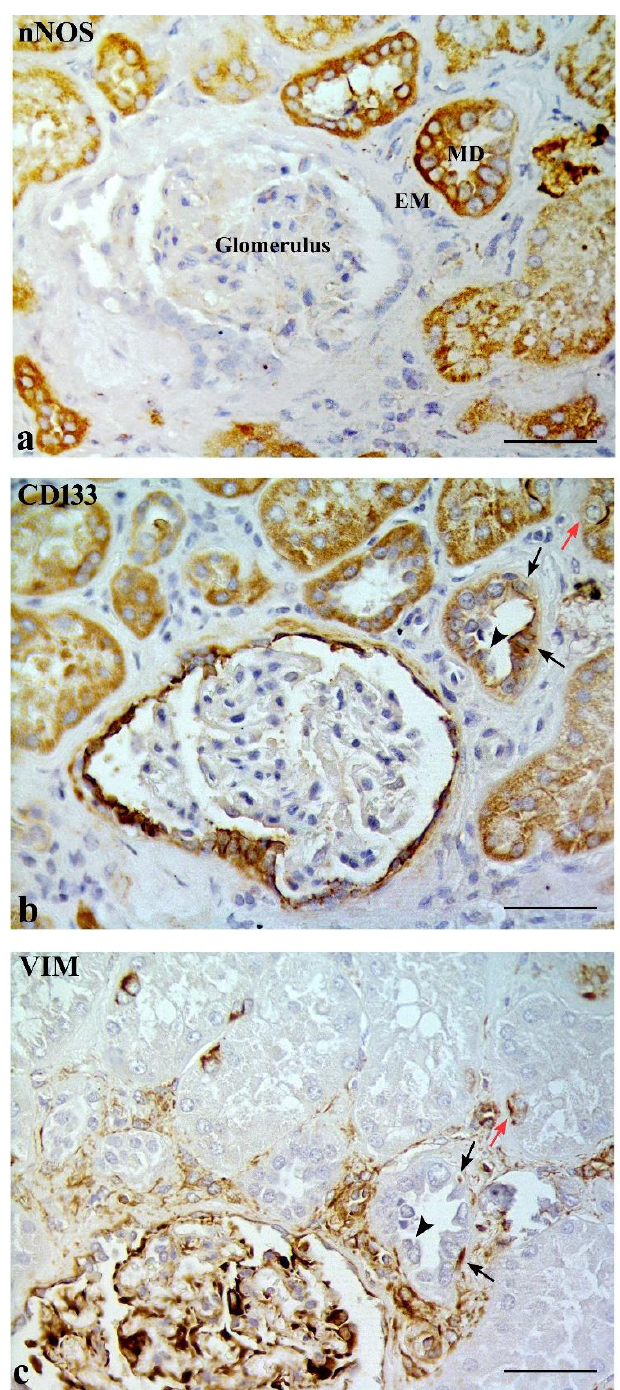
Figure 5. nNOS ( a ), CD133 ( b ) and VIM ( c ) expression in three serial sections of the same macula densa (MD). Two CD133-positive cells are localized in DT cells adjacent to MD (black arrows). The same cells are also positive for VIM in the basal pole (black arrows in ( c )). The CD133-negative cell in MD (black arrowhead in ( b )) is VIM-positive (black arrowhead in ( c )). CD133 (red arrow in ( b )) and VIM (red arrow in ( c )) are co-expressed in a tubular cell. EM, extraglomerular mesangium. Scale bar: 50 µm.